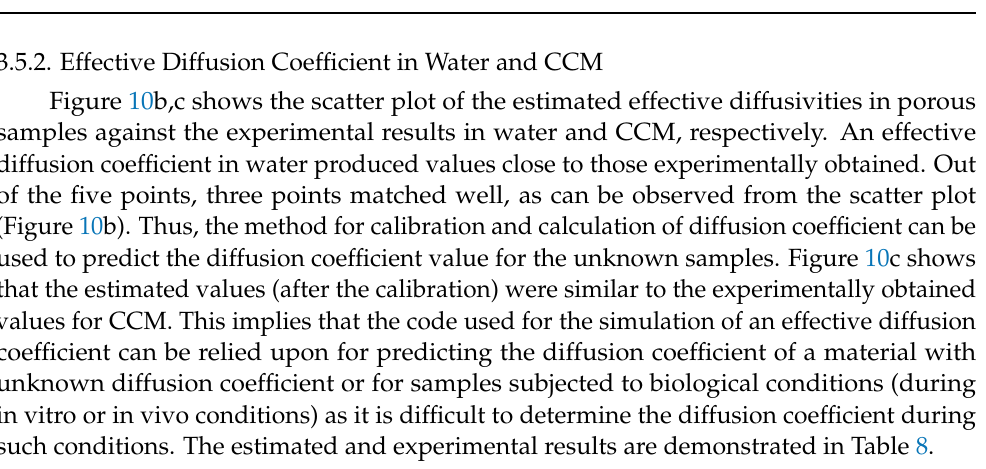
Table 8. Estimated and experimental effective diffusivities of selected scaffolds at 37 ◦ C. Sample